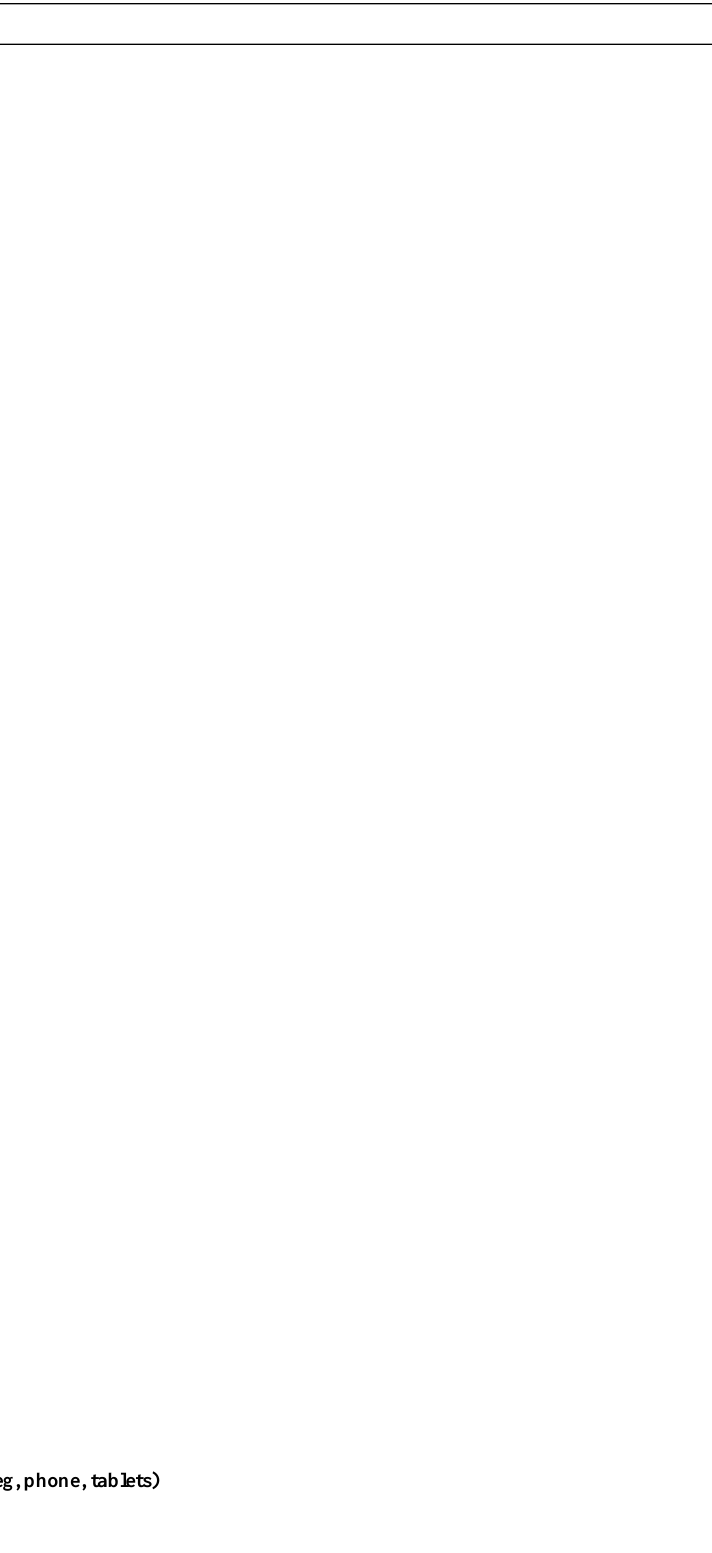
Table 2. Sample characteristics